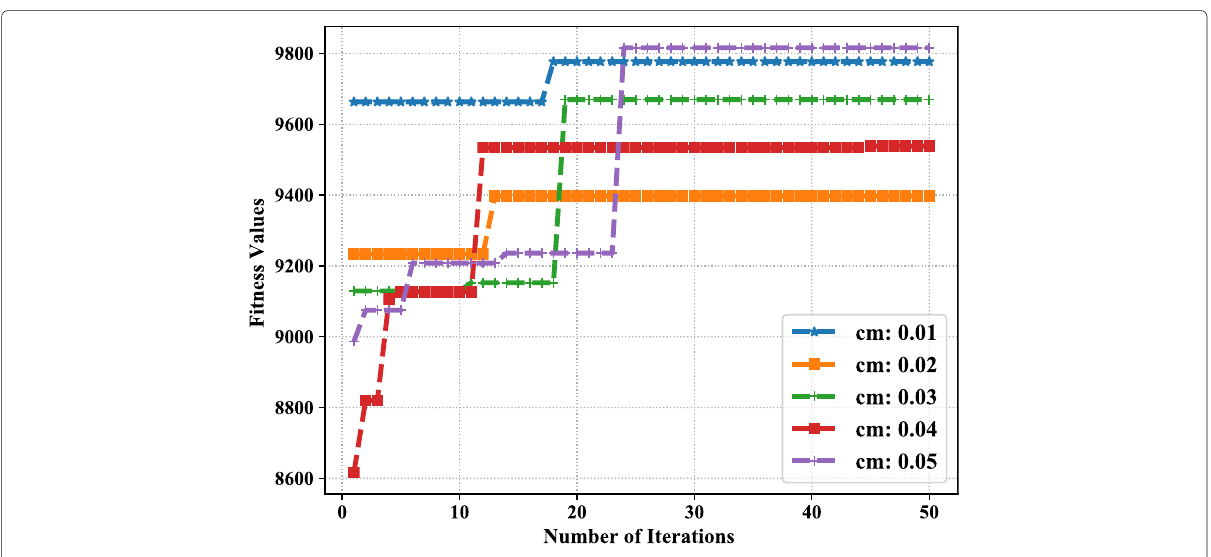
Fig. 6 Fitness values with different values of mutation probability